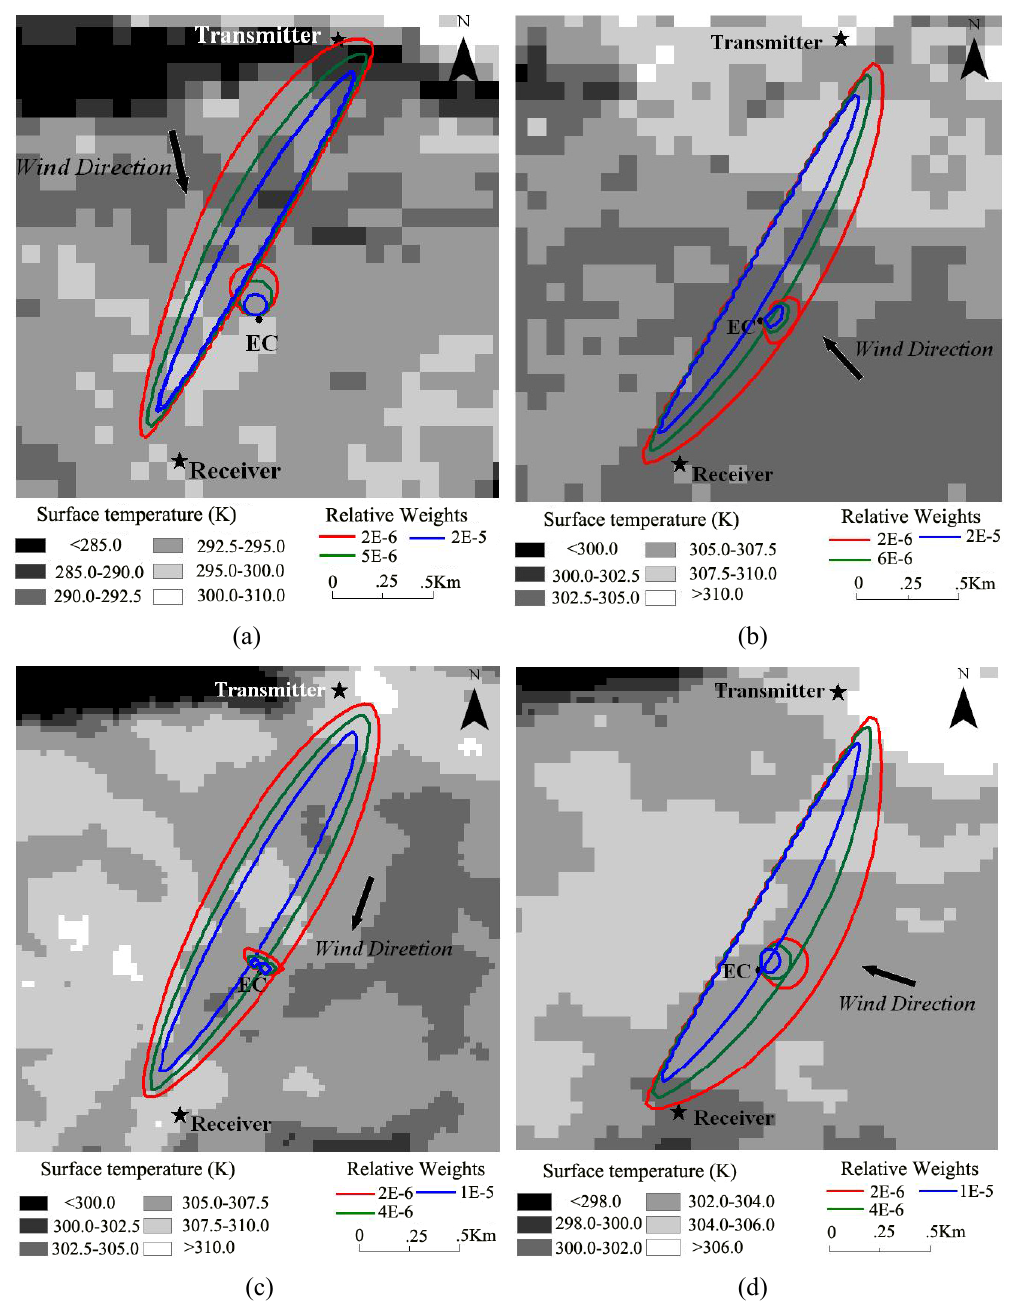
Figure 10. Distribution of the surface temperature measured by ASTER and TM passing time over the source areas of the EC and LAS (a) 25 March 2008, ASTER; (b) 15 July 2008, ASTER; (c) 21 April 2009, TM; (d) 24 June 2009, TM (source area of 95% contribution to the measured fluxes)